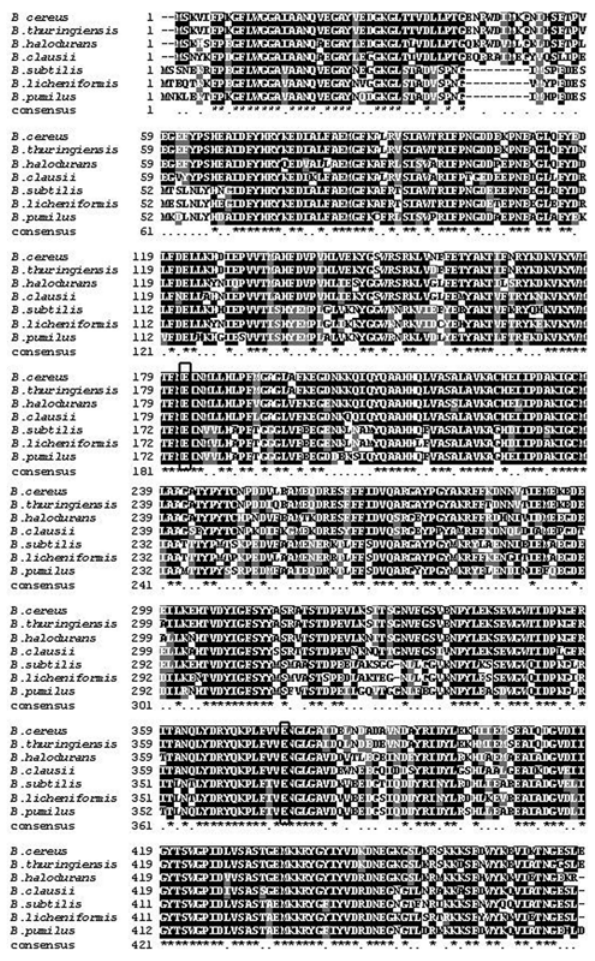
Figure 2 - Multiple alignment of amino acid sequence predicted from bgl H genes of the following Bacillus species: B, halodurans (gi 10173210); B. subtilis strain 168 (gi 7435440); B. cereus (gi 52144364); B. thuringiensis (gi 49477027); B. licheniformis (gi52082495); B. clausii (gi 56965550); and B. pumilus obtained in the present study. Asterisks showaminoacidsconservedinallsequencesanalyzed.Theregionsofcat- alytic amino acid residue Glu 175 and the catalytic nucleophile Glu 369 are